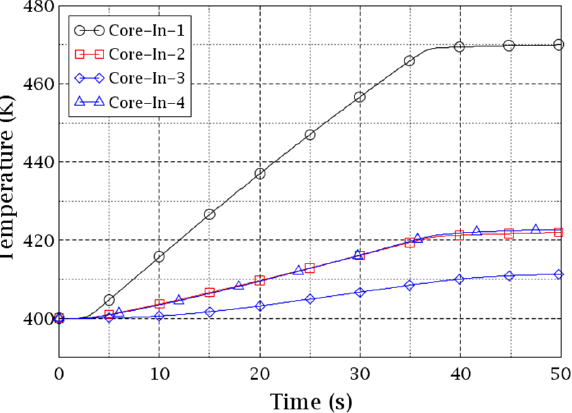
Figure 13. Evolution of the coolant temperature distribution at the core inlet CY-V (cell index is from Figure 10).